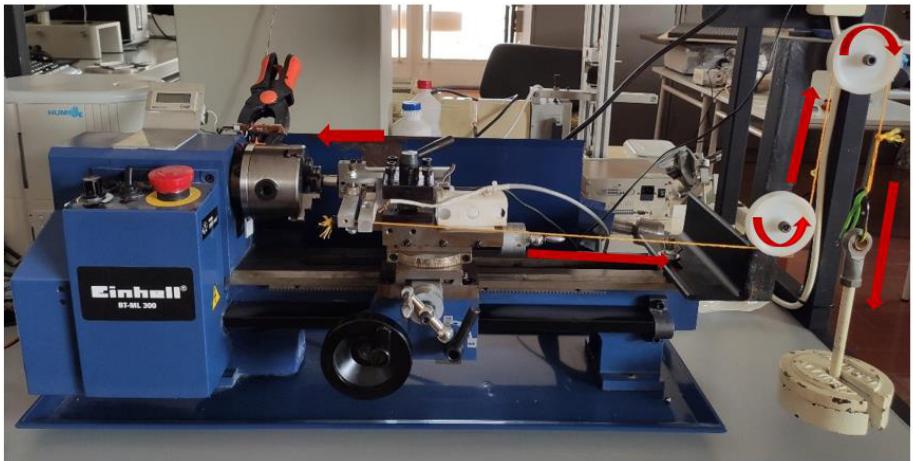
Figure 4. Pin-on-Disc Tribometer used in tribological tests (the red arrows indicate the direction of application of the force).